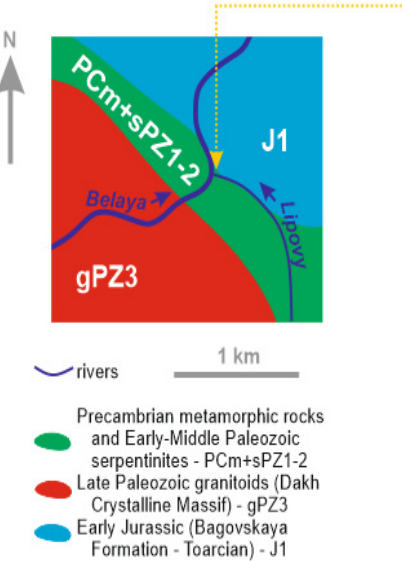
Figure 4. Lipovy locality: geological scheme and principal Jurassic lithology (hammer’s length is 40 cm). The nature of the contact between crystalline rocks and overlying Jurassic deposits shown on the scheme is not clear everywhere (it can be transgressive and tectonic).